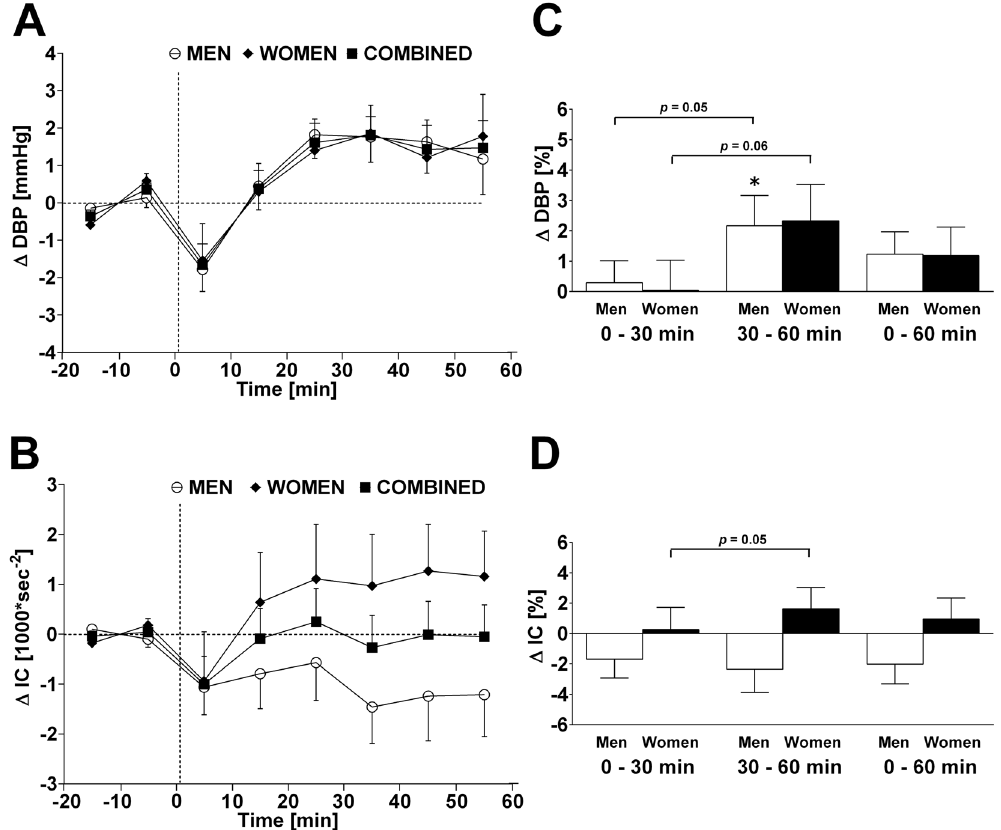
Figure 4. Left panels A and B: Time course of changes ( Δ ) from baseline in diastolic blood pressure (DBP) and index of contractility (IC), respectively. Open circle ( ○ ) = men; closed diamond ( ♦ ) = women; closed square ( ■ ) = combined men and women. Right panels C and D represent mean percentage changes in DBP and IC relative to baseline. Time 0 denotes four minutes after the water drink with calculating a subsequent average over the following 30 minutes, 30 to 60 minutes, and 0 to 60 minutes post-drink, respectively, which were subtracted from each baseline level and presented as deltas. * P < 0.05 statistically significant difference over time from baseline values (right panel). All values are reported as means ±